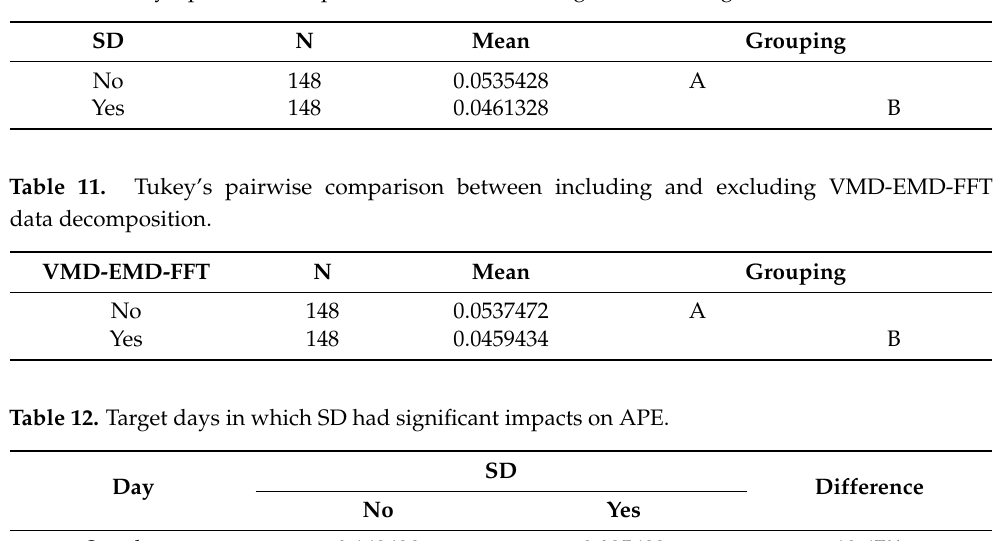
Table 10. Tukey’s pairwise comparison between including and excluding SD.